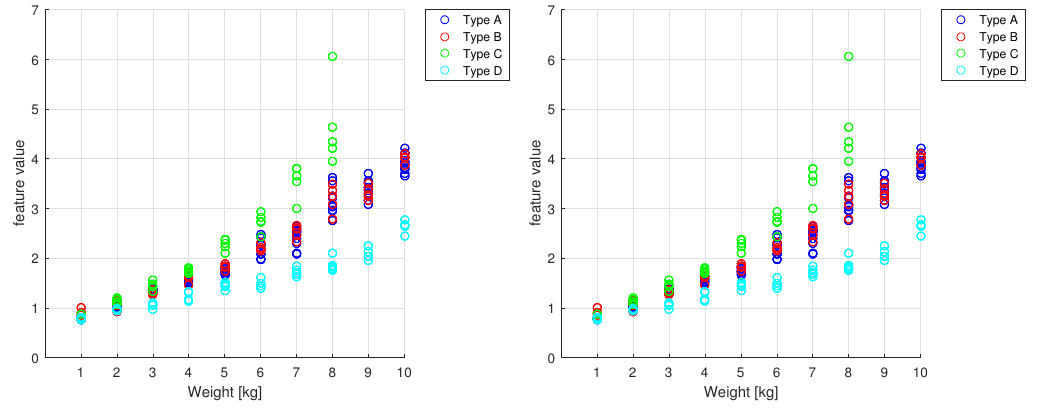
Figure 6. Example of features related to the drum torque as a function of the